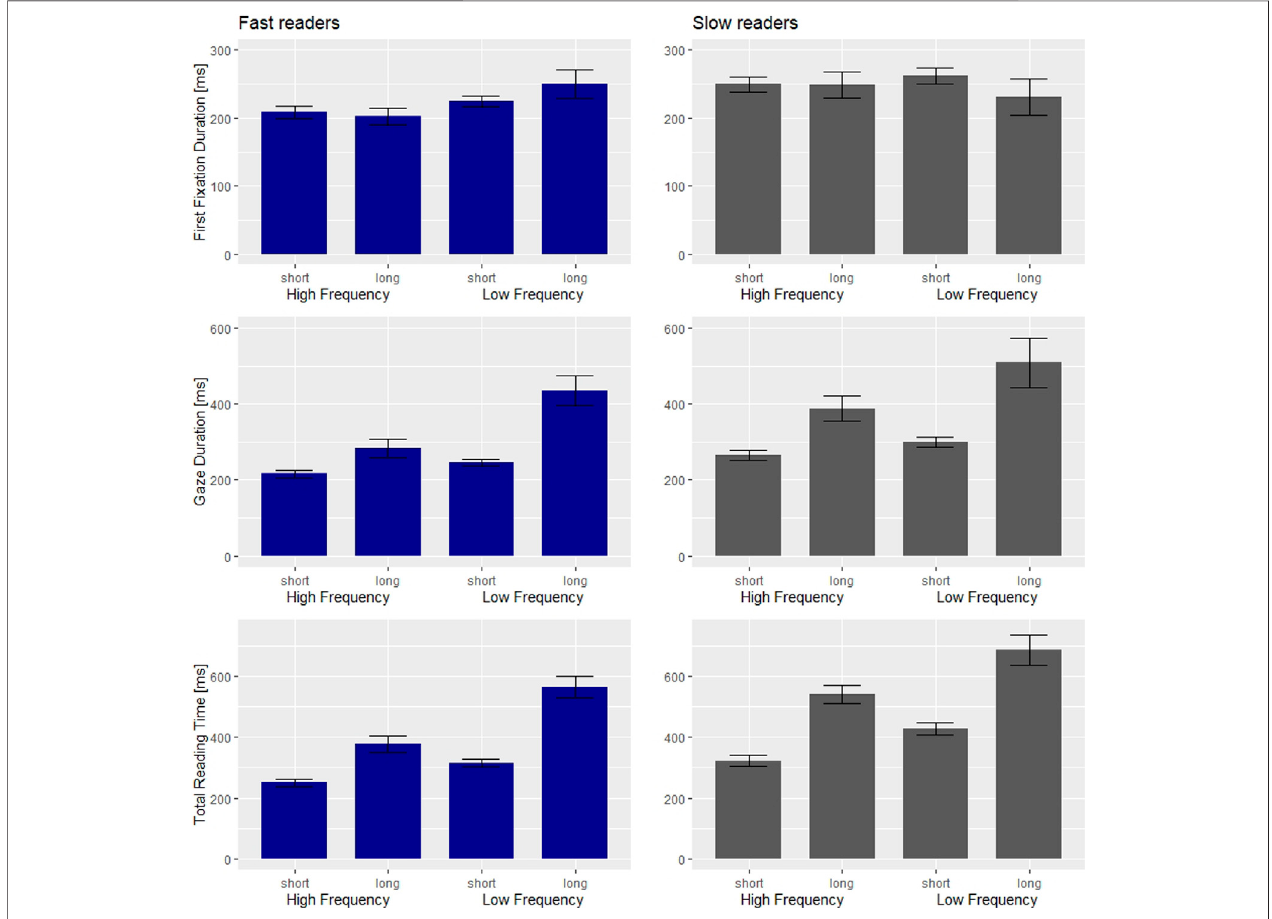
FIGURE 1 | Mean fi rst fi xation duration (top) , gaze duration (middle) and total reading time (bottom) (in ms) for short and long words of high and low frequency. Groups are represented as follows: fast readers in blue on the left, slow readers in grey on the right.